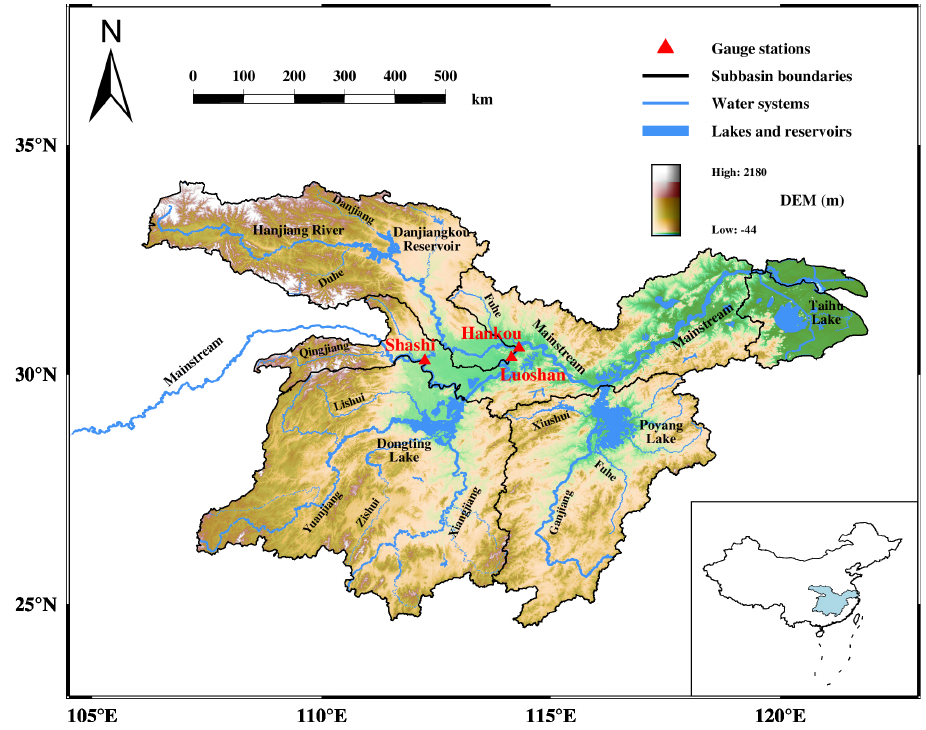
Figure 1. Location map of Hankou, Shashi, and Luoshan in the middle and lower reaches of the Yangtze River.